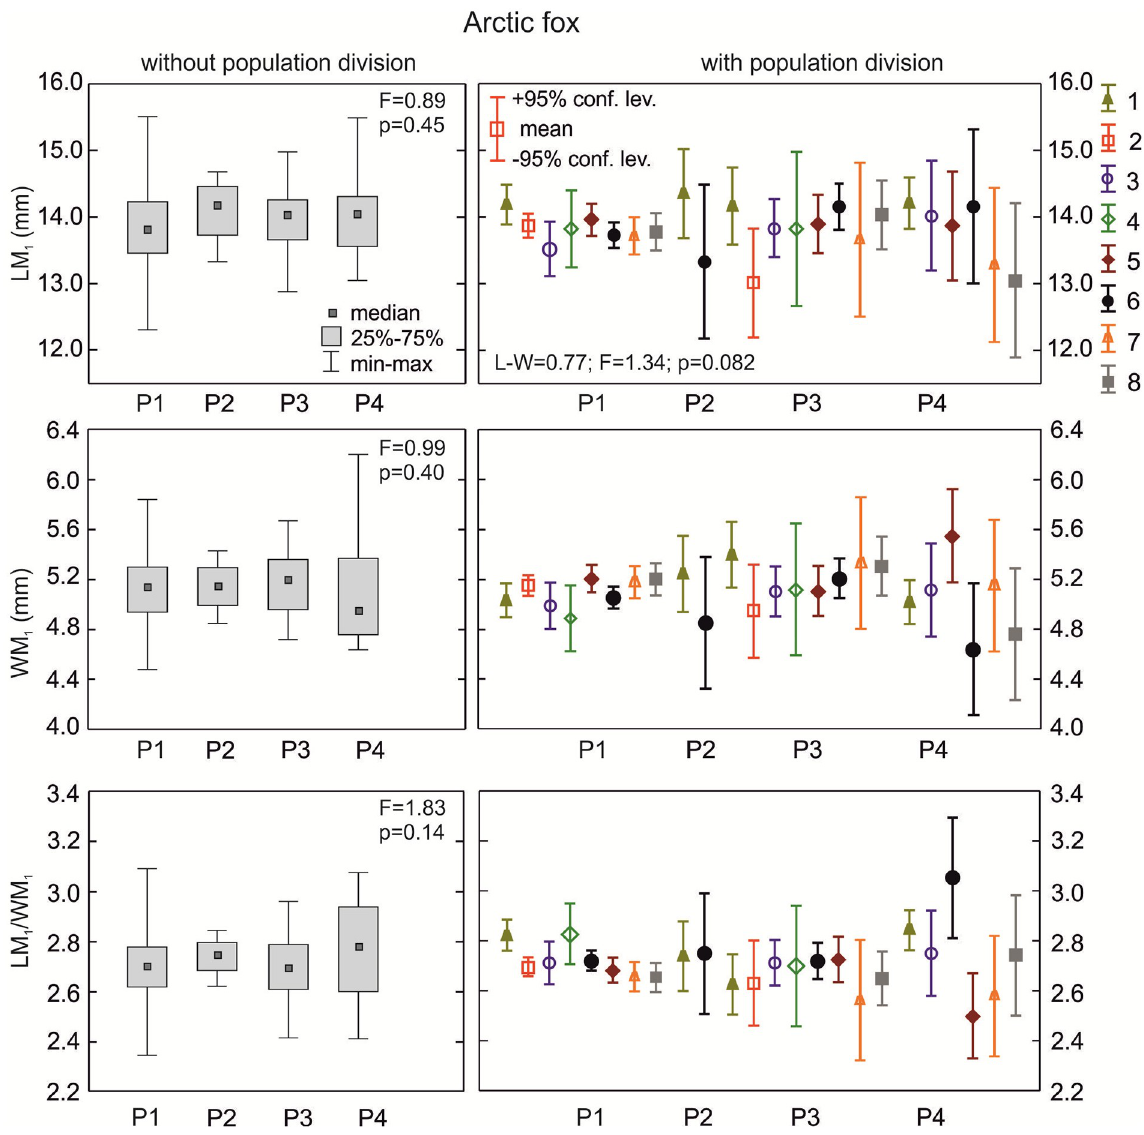
Fig 9. Comparison of median values for length, width, and size proportion of M 1 between various group P morphotypes in the arctic fox with and without population division. Illustrations of group P morphotypes are shown in Fig 2. Information about the samples can be found in Table